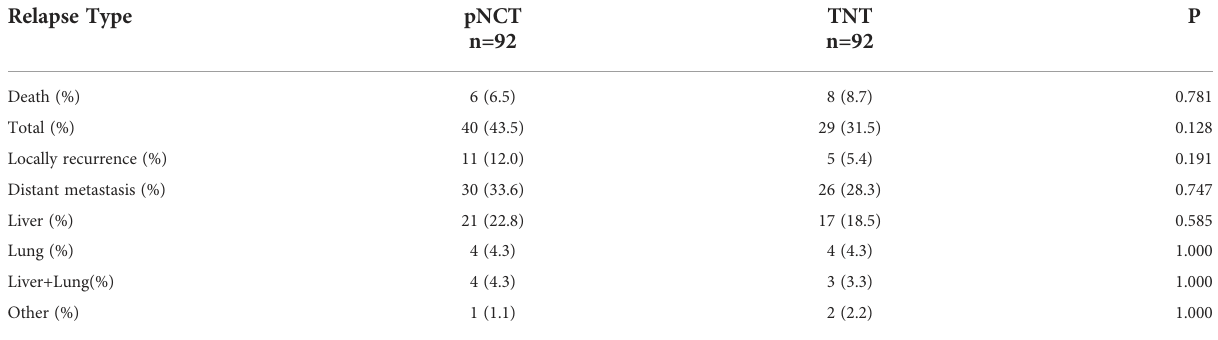
TABLE 4 Comparison of outcomes of